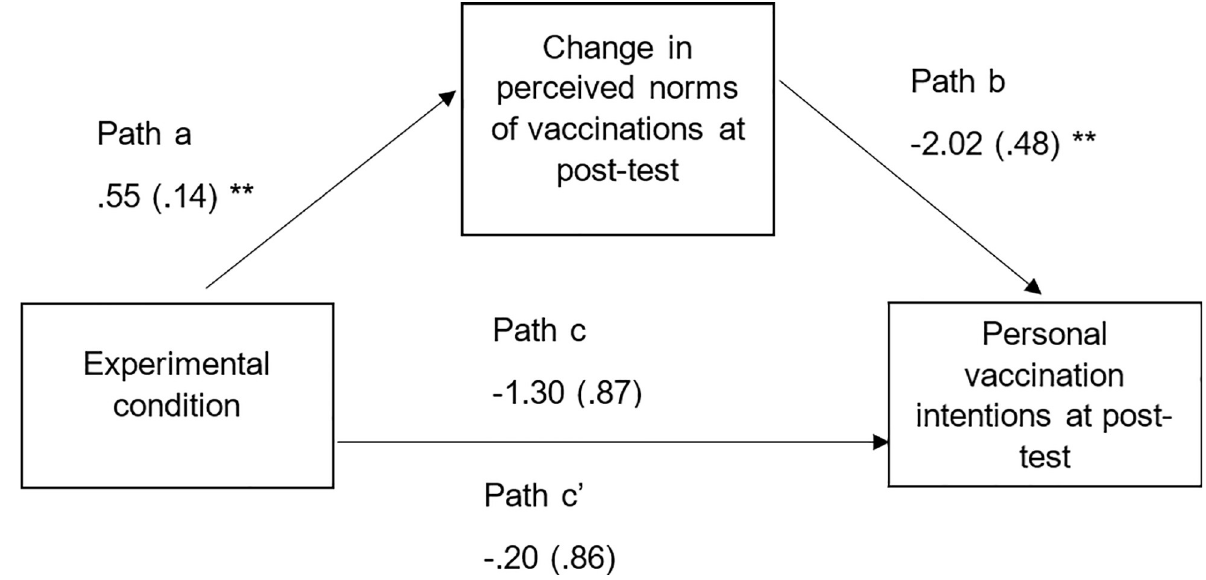
Fig 3. Model 4 showing indirect only mediation of the experimental condition on vaccination intentions through increased perceived norms of vaccination intentions. �� = p < .001.